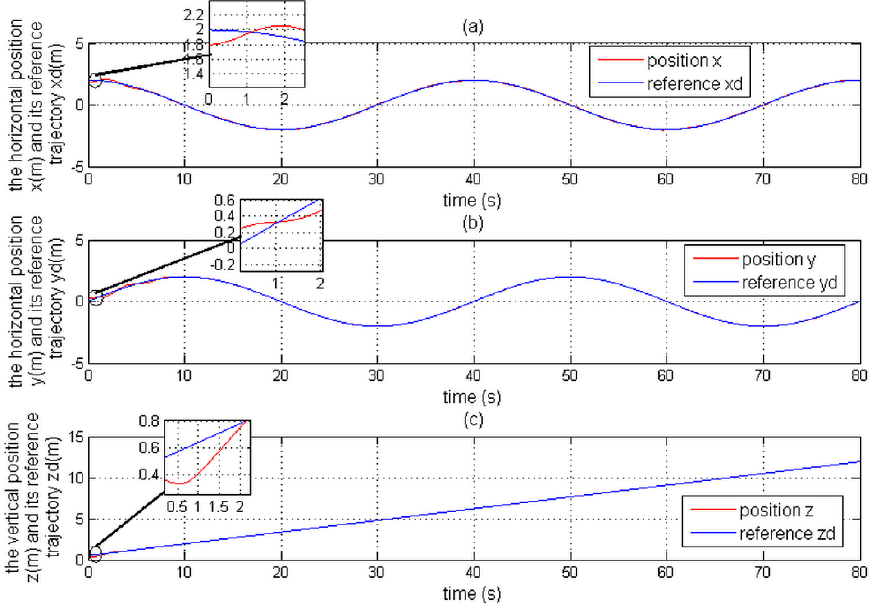
Figure 20. The position tracking evolution obtained by the CMTC: ( a ) x -position (m) and its reference trajectory x d (m); ( b ) y -position (m) and its reference trajectory y d (m); ( c ) z -position (m) and its reference trajectory z d